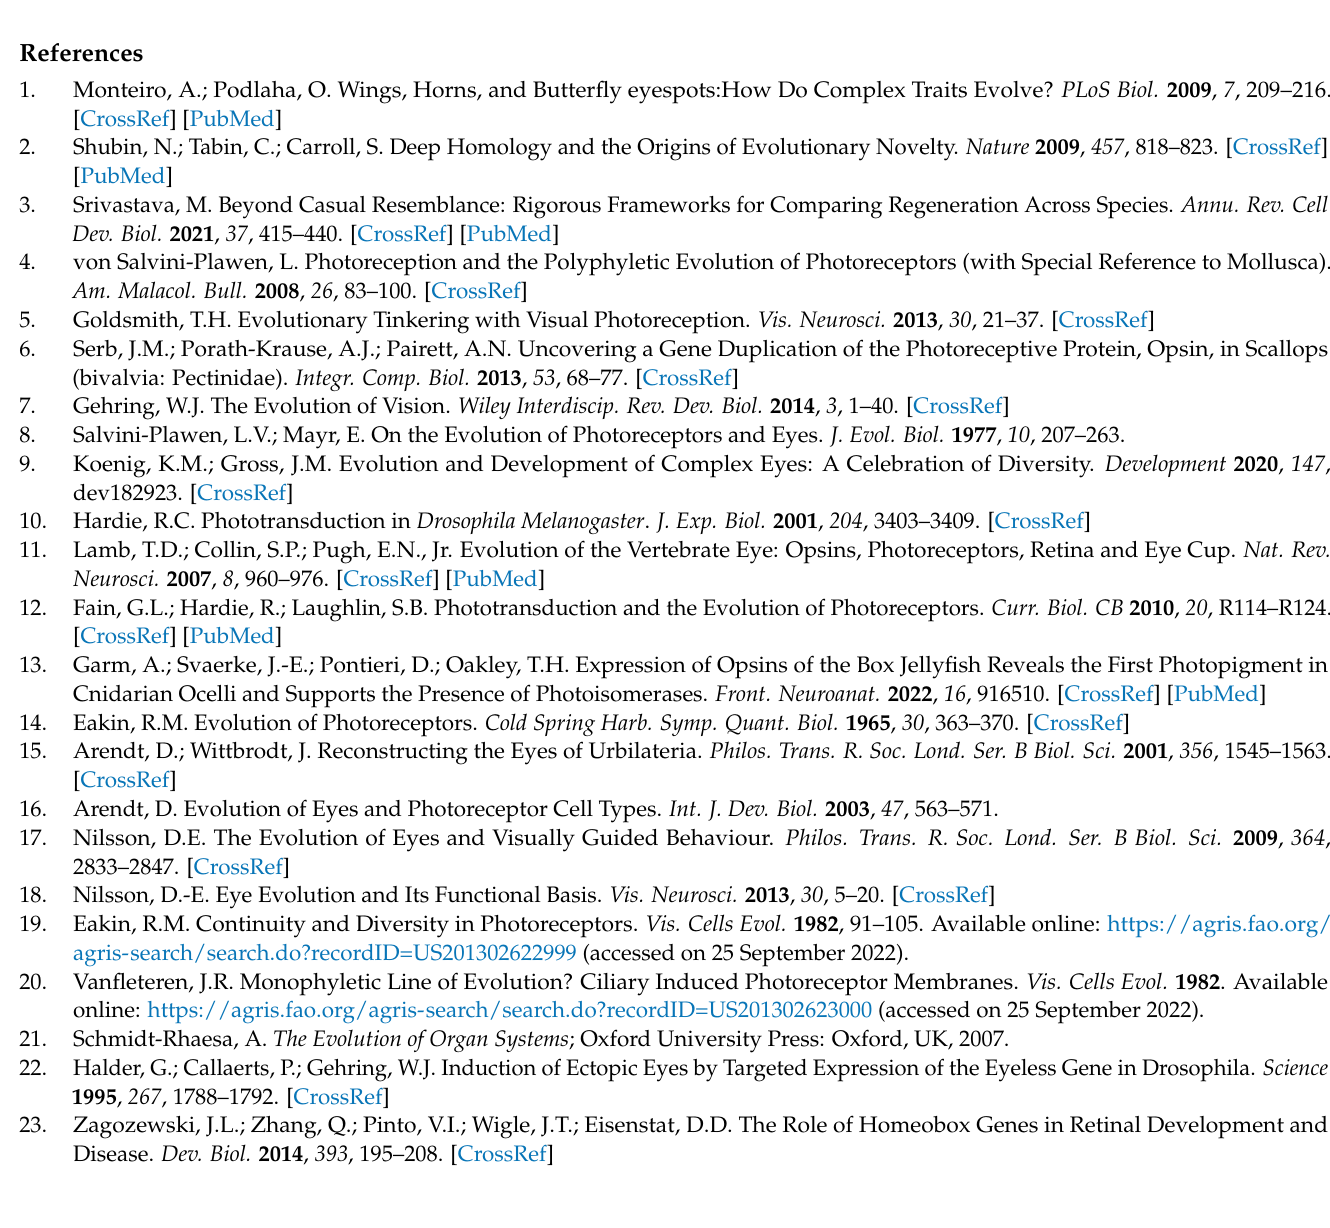
References for Figure 1. Table S2: Accessions for Cnidarian